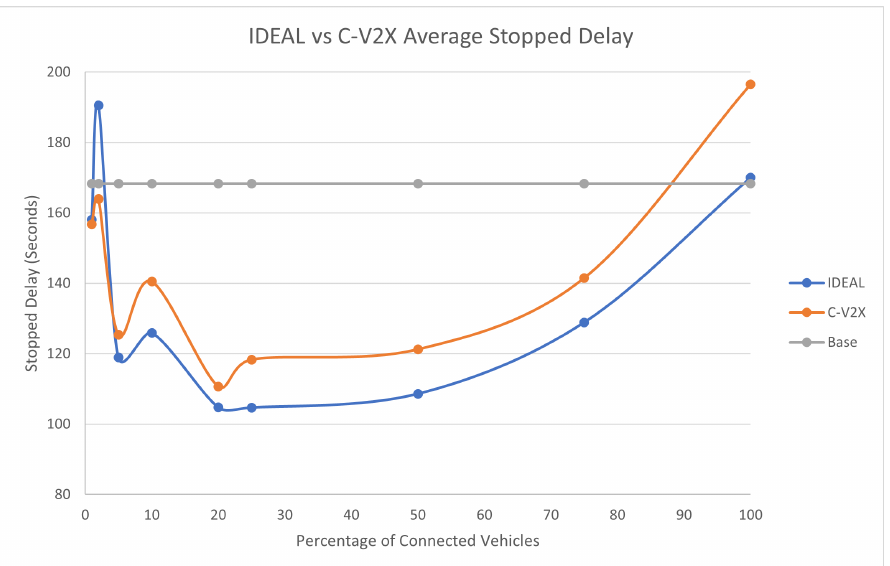
Figure 6. Average network-wide Stopped Delay of Energy-Efficient dynamic routing application using IDEAL and C-V2X communication on LA road network with traffic demand of scale factor